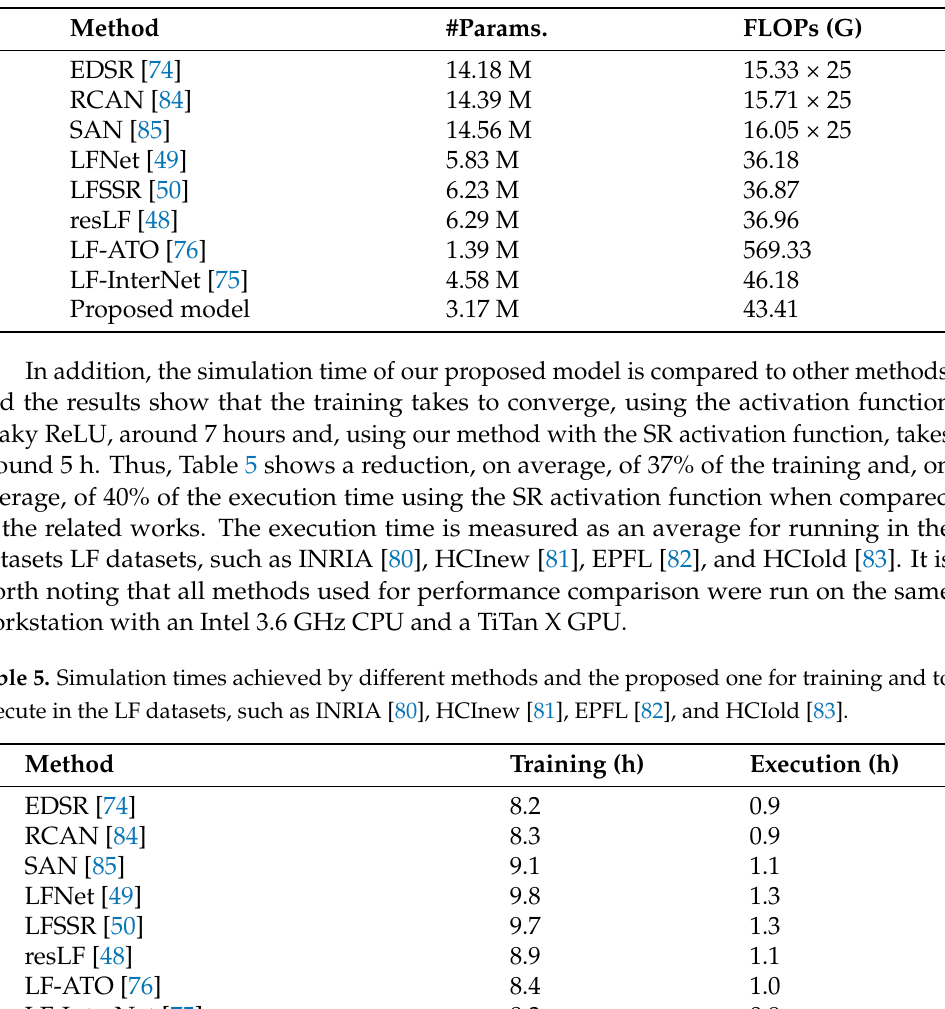
Table 4. Comparisons of our method to others, using number of parameters, #Params, as well as FLOPs, using the SR activation function.